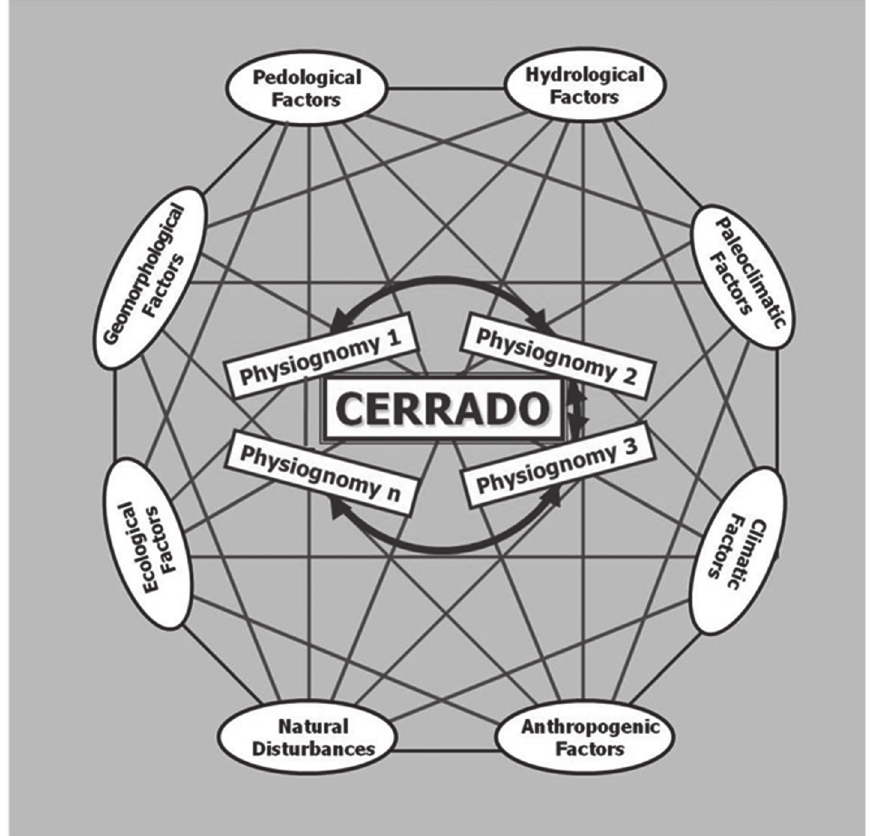
Figure 1 - Schematic representation of the inter-relations among types of factors acting on the configuration of different Cerrado